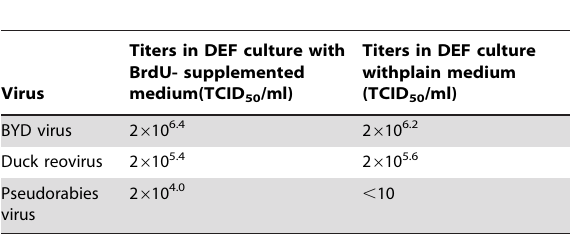
Table 1. Results of BrdU inhibitory assay in DEF